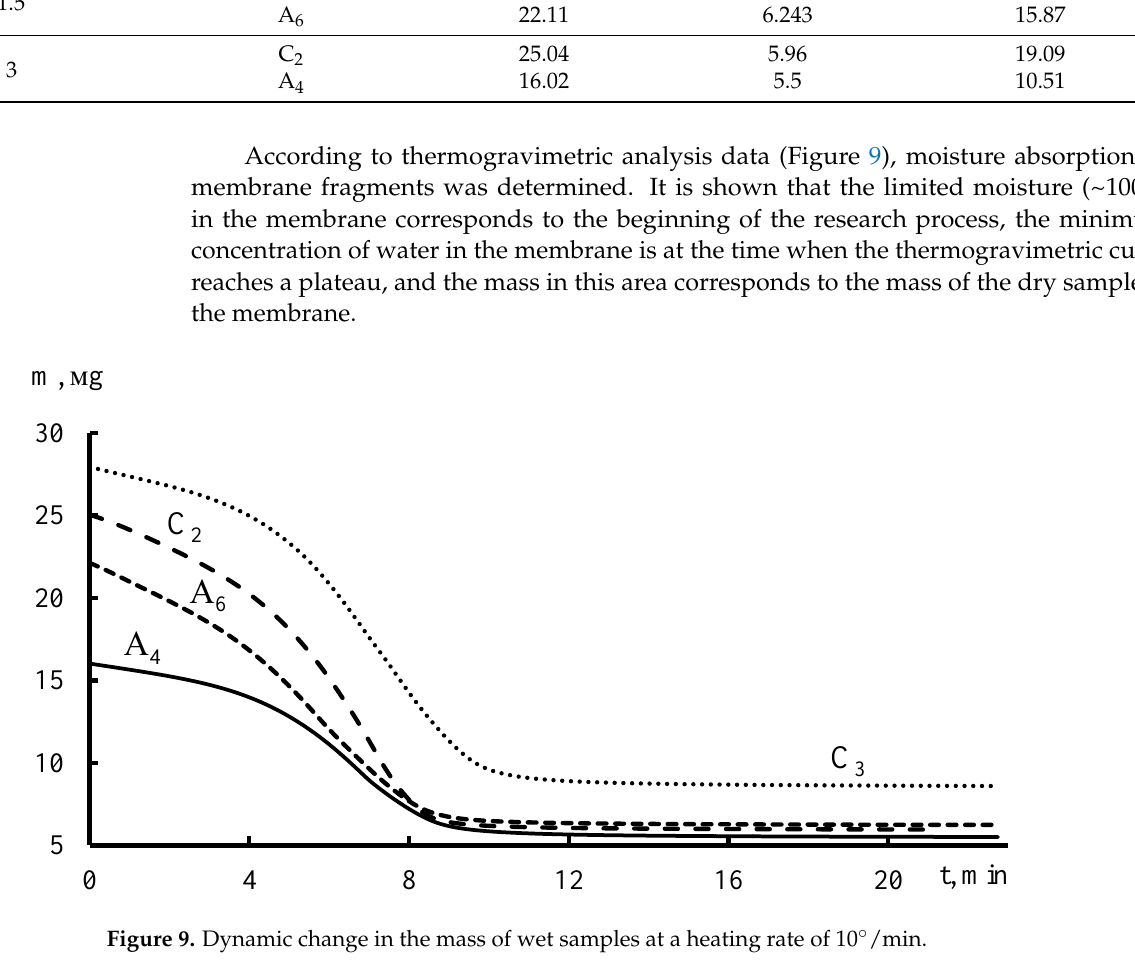
Figure 9. Dynamic change in the mass of wet samples at a heating rate of 10°/min.